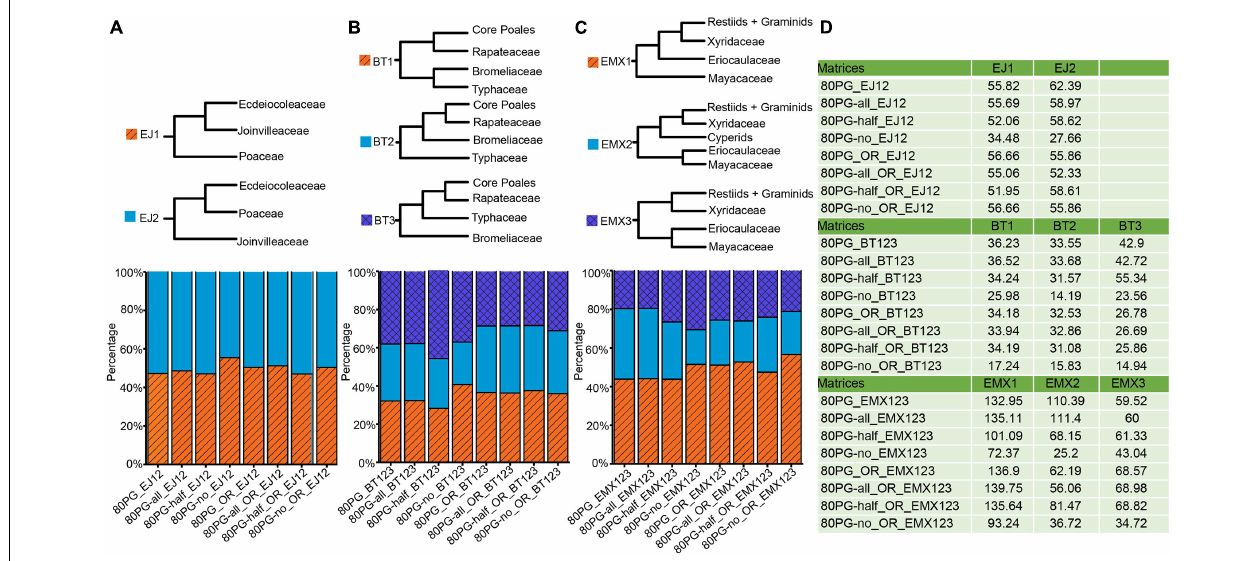
FIGURE 3 | Proportions of phylogenetic signals ( (cid:49) GLS) supporting alternative topologies of three conflicting nodes for each of 8 data matrices. (A) Proportions of (cid:49) GLS supporting either of two alternative relationships among Ecdeiocoleaceae, Joinvilleaceae, and Poaceae family across eight matrices; (B) Proportions of (cid:49) GLS supporting either of the three alternative relationships among Bromeliaceae, Rapateaceae, Typhaceae, and the rest across eight matrices; (C) Proportions of (cid:49) GLS supporting either of the three alternative relationships among Eriocaulaceae, Mayacaceae, Xyridaceae, cyperids and the rest across eight matrices; (D) the summed (cid:49) GLS values for each matrix. Note: -all, -half, and -no mean that using Gblocks allow gap positions with all, with half, and none. The value − 12 means 1st + 2nd condon positions of the matrix; The value − 3 means the 3rd codon position of the matrix. The notations _OR and _outlier_removed mean removing outlier genes.